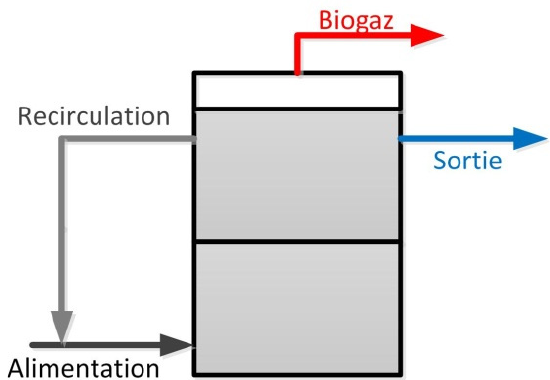
Figure 10. High efficiency anaerobic digestion for effluents—Proveo